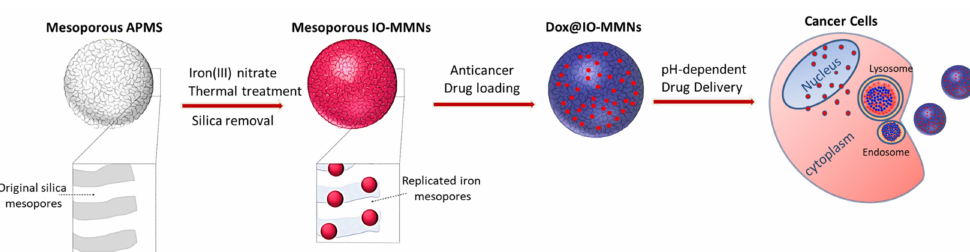
Figure 1. Schematic illustration for the preparation of iron oxide mesoporous magnetic nanostructures (IO-MMNs) from an acid-prepared mesoporous sphere (APMS) silica template and their subsequent loading with anticancer drugs for pH-dependent drug